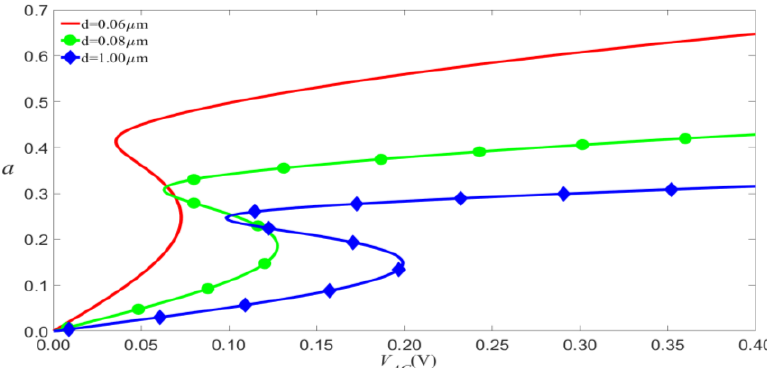
Figure 19. Amplitude of the response as a function of the load’s amplitude of primary resonance with V DC = 4 V and σ = 0.05 for d